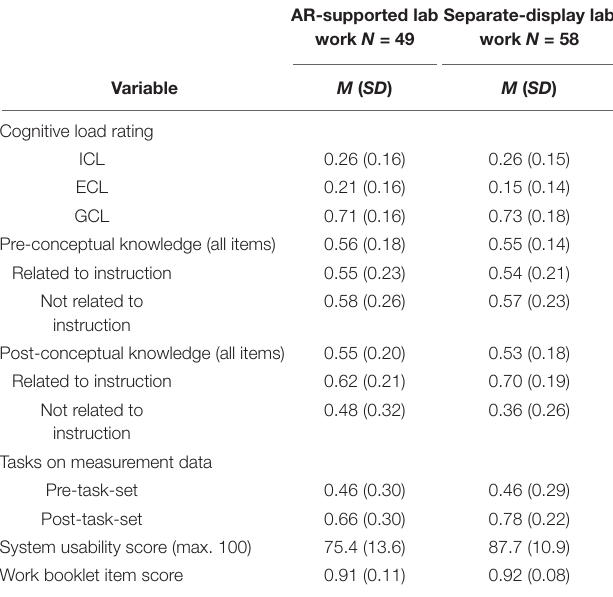
TABLE 1 | Standardized means ( M ) and standard deviations ( SD ) for dependent variables, separated by AR and separate-display